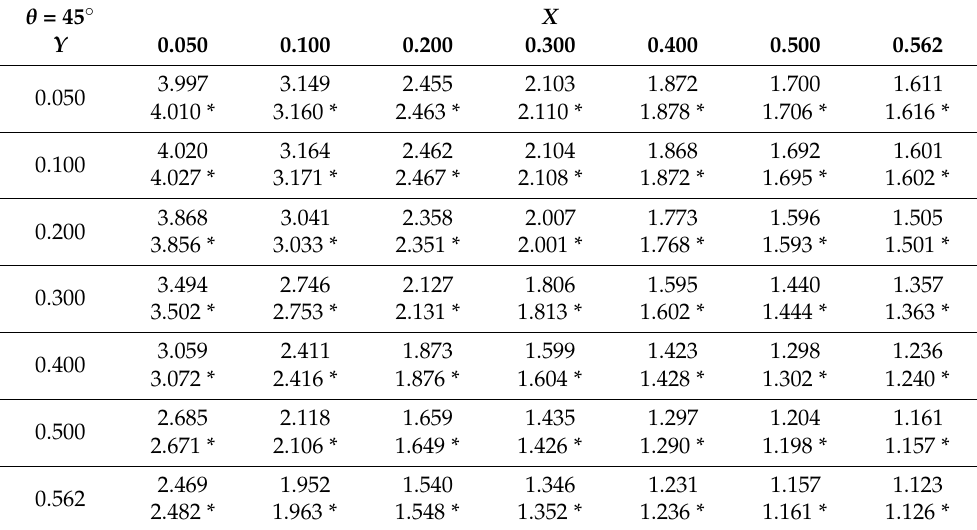
Table 3. Comparison of K tb values calculated using Equation (A2) (*) to the corresponding FEM results for various X and Y , while T / a = 1 and θ = 45 ◦ .